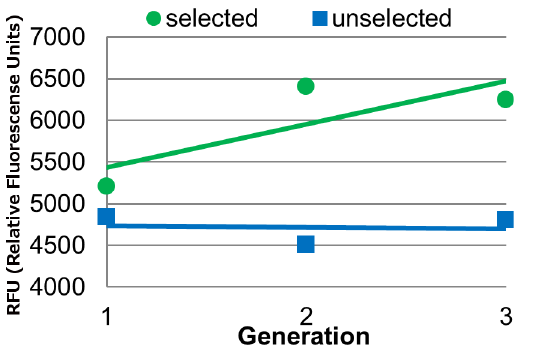
Fig 3. Effect of selection on seed fluorescence. Data points are mean fluorescence values versus generation, shown with the linear regression trend line. The equations of the lines for the selected and unselected populations are y = 520.43x + 4910.3 (R 2 = 0.6397) and y = -15.242x + 4,747.8 (R 2 = 0.0072) respectively.